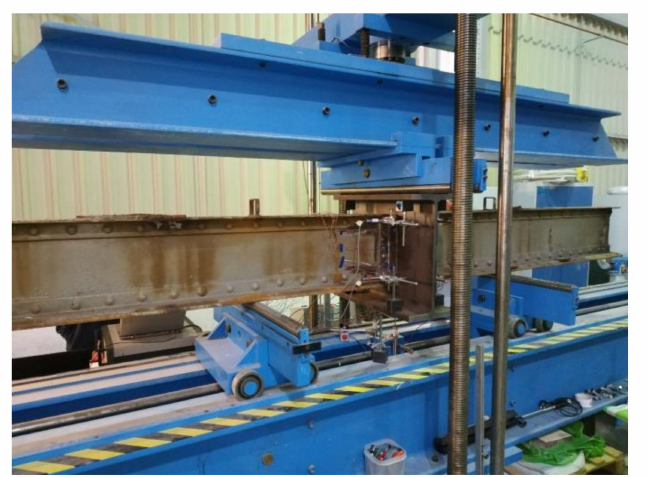
Figure 7. Laboratory test of the non-strengthened